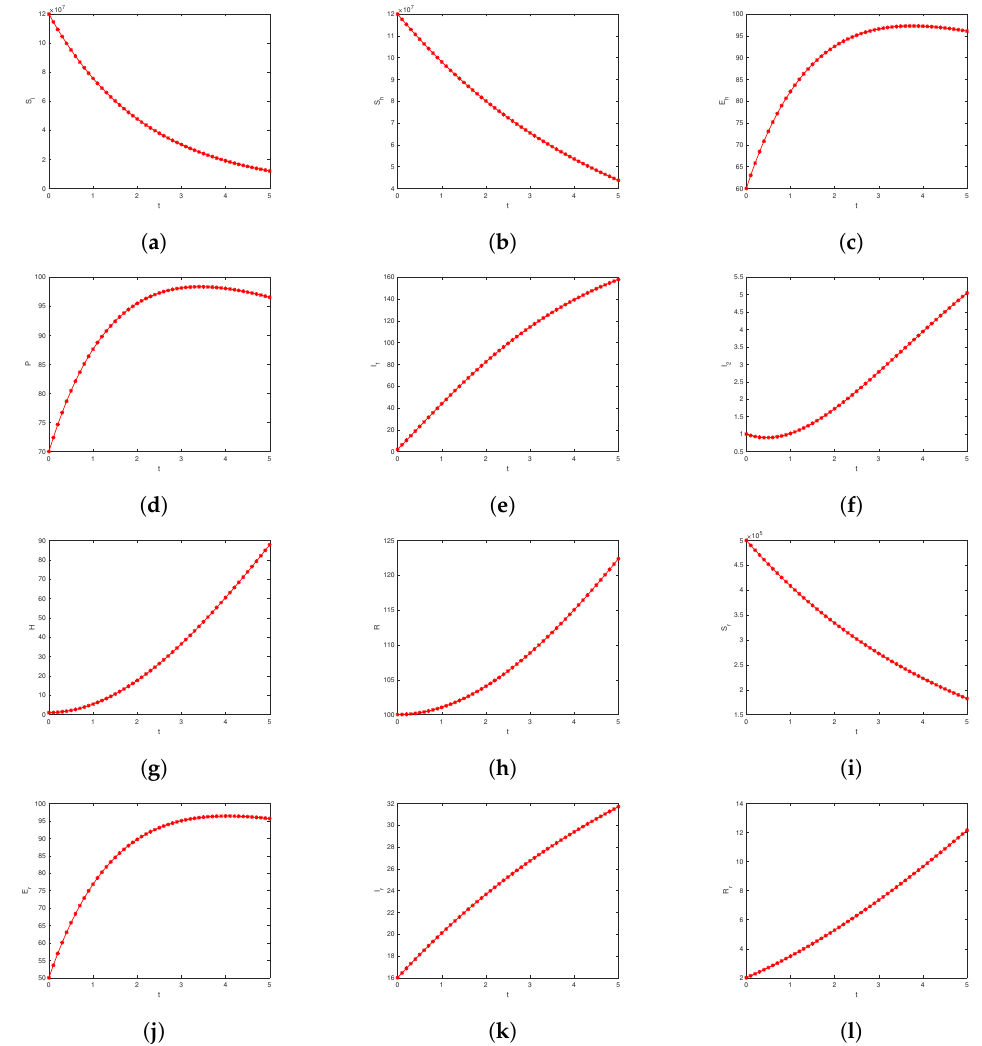
Figure 3. Simulation results portraying the mpoxv dynamics of the individual compartments of the governing model (1) .